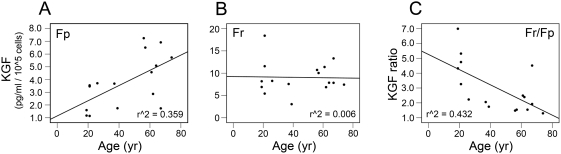
Secretion of KGF by Fp and Fr as a function of donor's age.Evolution of secretion was estimated by linear regression in a cohort of 16 different pairs of Fp and Fr obtained from independent donors, ranging from 19 to 74 years old. Secretion of KGF was quantified. Values are expressed in pg/ml per 105 cells. (A) KGF secretion by Fp samples. (B) KGF secretion by Fr samples. (C) KGF secretion ratio [Fr/Fp].